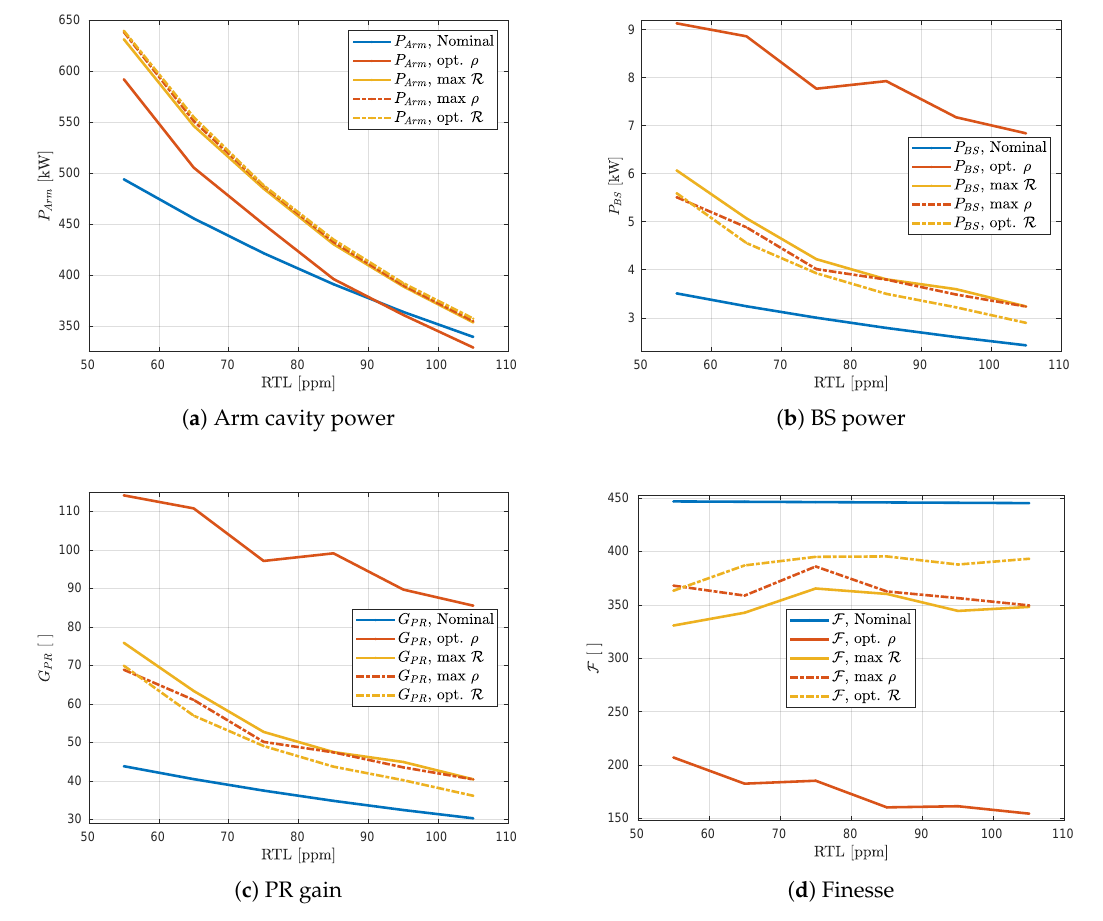
Figure 7. Additional parameters calculated by the algorithm but not used in its search criteria. ‘Opt’ corresponds to an optimal primary parameter, while ‘max’ corresponds to a maximum secondary parameter within a predefined budget of the optimal primary parameter found. Nominal configurations that use the currently expected IM, PRM, and SRM transmittances are shown for